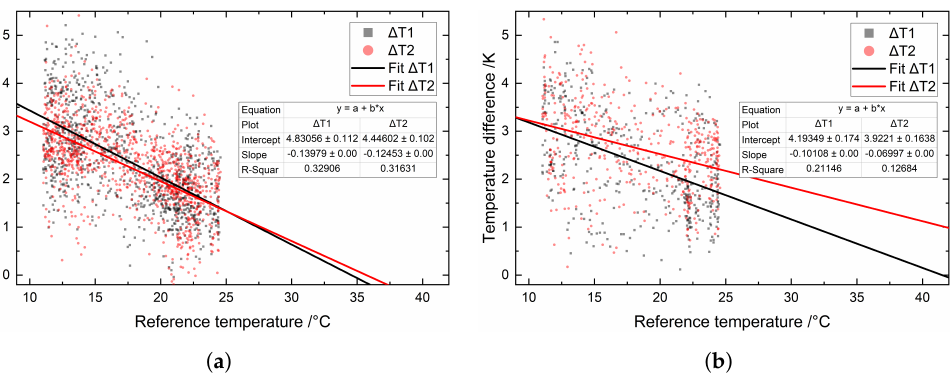
Figure 12. Temperature difference at the TEG versus ambient temperature measured by a weather station. A linear fit is shown to extrapolate the zero-crossing with the x-axis. At this point, the temperature difference at the TEG becomes zero and no thermal harvesting is possible. ( a ) First goat with both housings having a similar thermal connection. ( b ) Second goat with less data